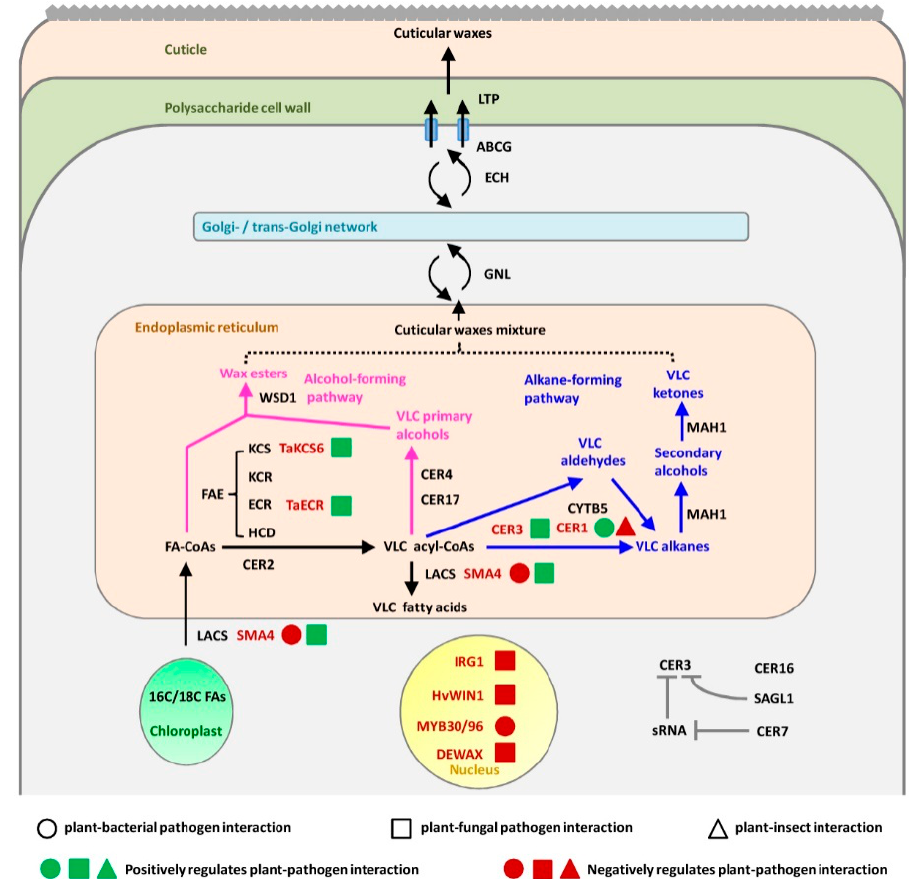
Figure 1. A simplified model for the cuticular wax biosynthesis and its roles in regulating plant–pathogen interactions. The biosynthesis of the cuticular wax mixture starts from the elongation of C16 or C18 fatty acid-coenzyme A (CoA) by fatty acid elongase (FAE) complex and ECERIFERUM2 (CER2) proteins. The elongated very-long-chain (VLC) acyl-CoAs are then modified into aldehydes, alkanes, secondary alcohols, and ketones by an alkane-forming pathway (shown in blue) or into primary alcohols and wax esters by an alcohol-forming pathway (shown in pink). Names shown in red denote proteins involved in the regulation of plant-pathogen interactions. For steps involving multiple paralogs, only the gene subfamily name is given in black. Circle, square, and triangle denote plant-bacterial pathogen interaction, plant-fungal pathogen interaction, and plant–insect interaction, respectively. Positive and negative regulations of plant–pathogen interaction are individually shown in green and red colors, respectively. The model for the cuticular wax biosynthesis was built on Yeast and Rose. 2013, and Lewandowska et al., 2020 [8,49]. Increasing evidence from studies in Arabidopsis revealed that the biosynthesis of cuticular waxes is regulated by multiple transcriptional regulators [49–51]. As the first reported transcriptional regulator, the Arabidopsis APETALA2-Ethylene responsive factor (AP2-EREBP)-type transcription factor WAX INDUCER1/SHINE1 (WIN1/SHN1) and its close homologs SHN2 and SHN3 activated cuticular wax biosynthesis by upregulation of